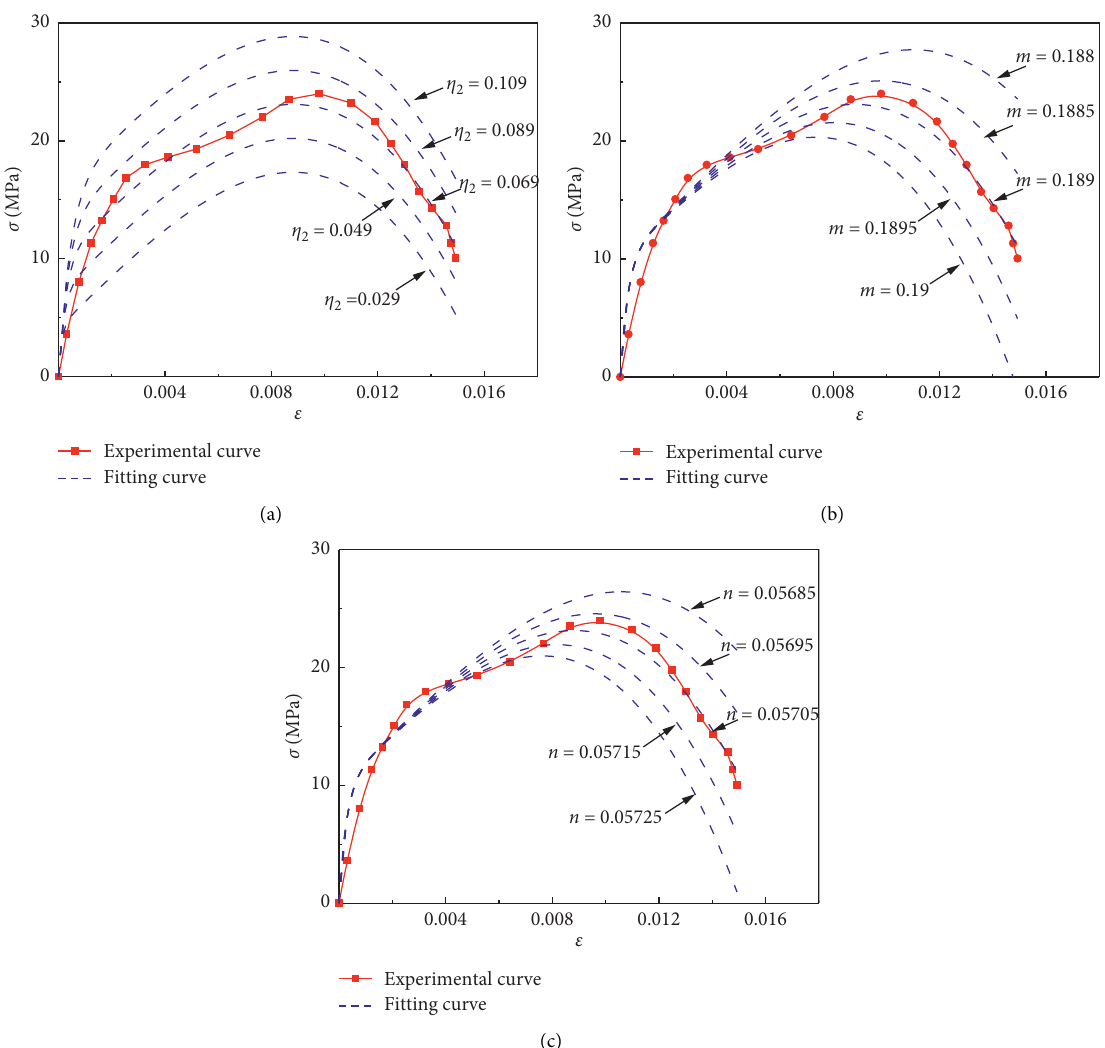
Figure 7: The influence of parameter values on constitutive curve. (a) η